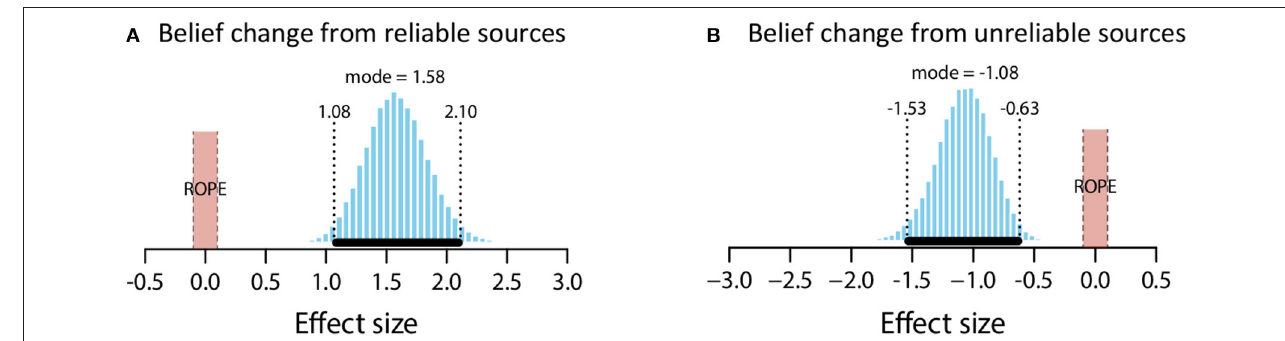
Frontiers in Psychology |